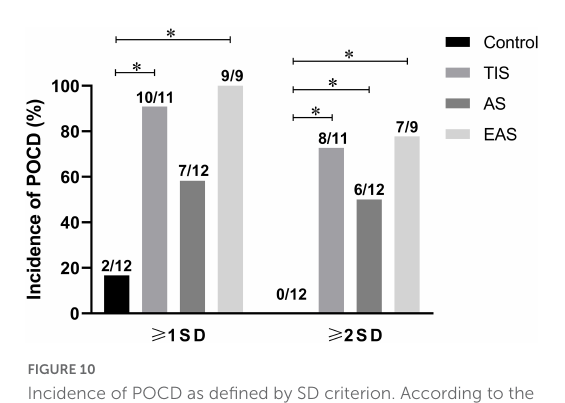
FIGURE10 Incidence of POCD as defined by SD criterion. According to the 1-SD criterion, the incidences of POCD in TIS and EAS mice were higher than those in controls. According to the 2-SD criterion, the incidences of major POCD in all three types of surgical mice were higher than those in controls. The chi-squared test was used for most data analysis, and the significance level was adjusted to 0.0083 according to Bonferroni’s method. ∗ P < 0.0083.